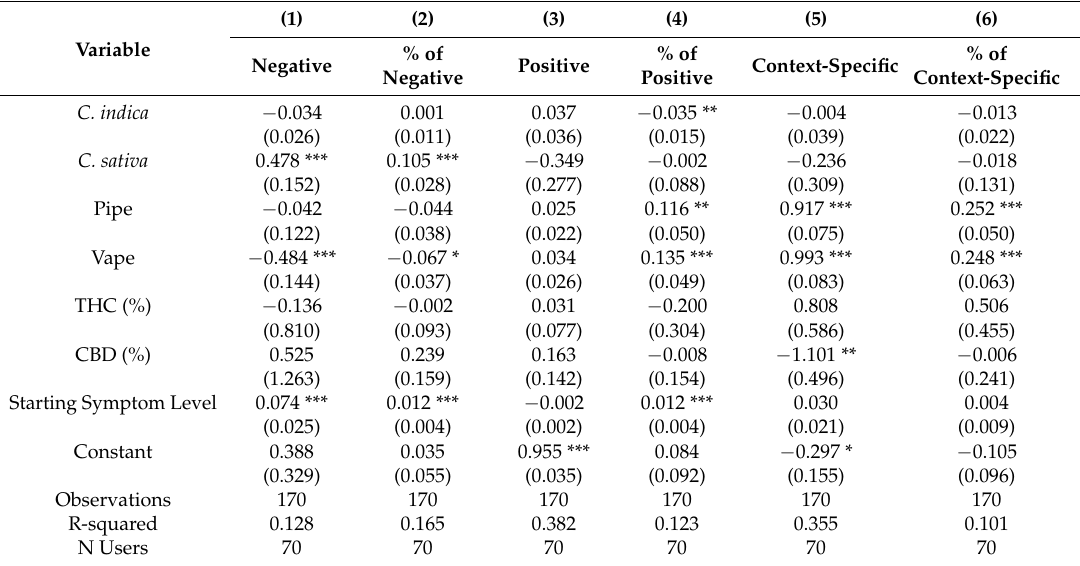
Table 3. Effects of Product Characteristics on Side Effects—Regression